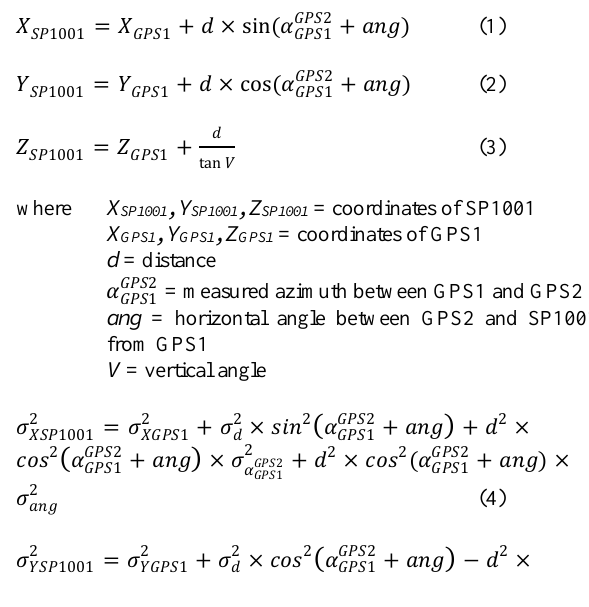
Figure 4. Depiction of the computation and georeferencing of ground-truth data; where GPS 1 and GPS 2 are two external GPS points, the azimuth from GPS 1 to GPS 2 , d the distance between GPS 1 and plot center SP1001 , and ang the horizontal 𝐺𝐺𝐺𝐺𝐺𝐺1𝐺𝐺𝐺𝐺𝐺𝐺2 𝛼𝛼 angle from GPS 1 to SP1001 . Black dots represent the ground points measured (green square) Nevertheless, despite these positions are considered as ground- truth data for this study, their errors are not null, and therefore the accuracy of the measurements must be considered before computing the differences between each DTMs and the one used as reference. Considering the process followed to compute the coordinates of ground-truth data, the two external GPS points have a known accuracy related to the GPS signal, instrument, and differential corrections. This accuracy is transmitted to the rest of the measured points by classic surveying measurements where distance, angle and set up errors of the total station were also added. Hence, this is a case of error propagation, where we calculated the accuracy related to each position point by using the approach based on Ghilani (2017) (see equations (4), (5) and (6)). As a result, the DTM generated from the ground-truth data measured by classic surveying measurements and used as reference in this study also has an